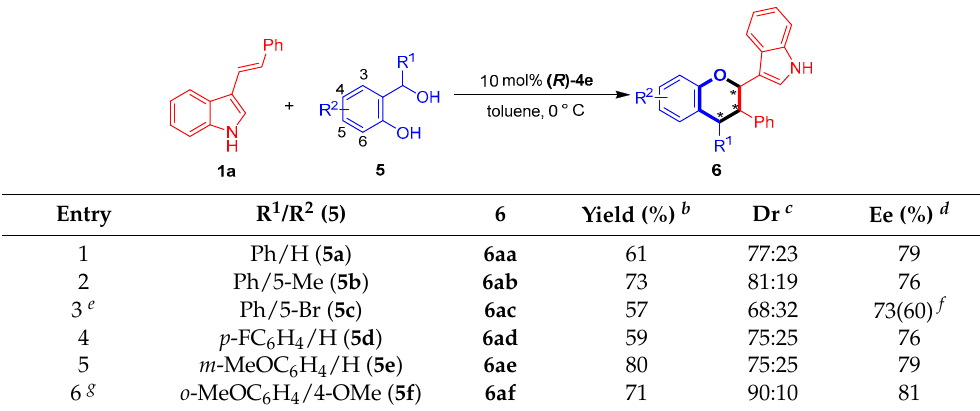
Figure 8. Relative configuration of 6ma . 3. Materials and Methods The detailed procedures for the synthesis and characterization of the products are given in Appendix A section. 4. Conclusions In summary, we performed catalytic asymmetric [2 + 4] cycloaddition of 3-vinylindoles with ortho -quinone methides and their precursors in the presence of chiral phosphoric acid. This approach was used to synthesize a series of indole-containing chroman derivatives with structural diversity in overall high yields (up to 98%), good diastereoselectivities (up to 93:7 dr) and moderate to excellent enantioselectivities (up to 98% ee). This approach not only enriches the chemistry of 3-vinylindole-inolved catalytic asymmetric cycloadditions but is also useful for the enantioselective synthesis of chiral chroman derivatives. Supplementary Materials: The following are available online. NMR and HPLC spectra of products 3 and 6 , NOE spectrum of product 6ma , X-ray single-crystal data for product 3na , and theoretical calculations of the reaction pathway. Author Contributions: Conceptualization, F.S.; Data curation, Y.-C.Z.; Investigation, S.-J.L., M.-S.T., K.-Y.L. and J.-Y.C.; Supervision, Y.-C.Z. and F.S.; Writing—original draft, Y.-C.Z.;